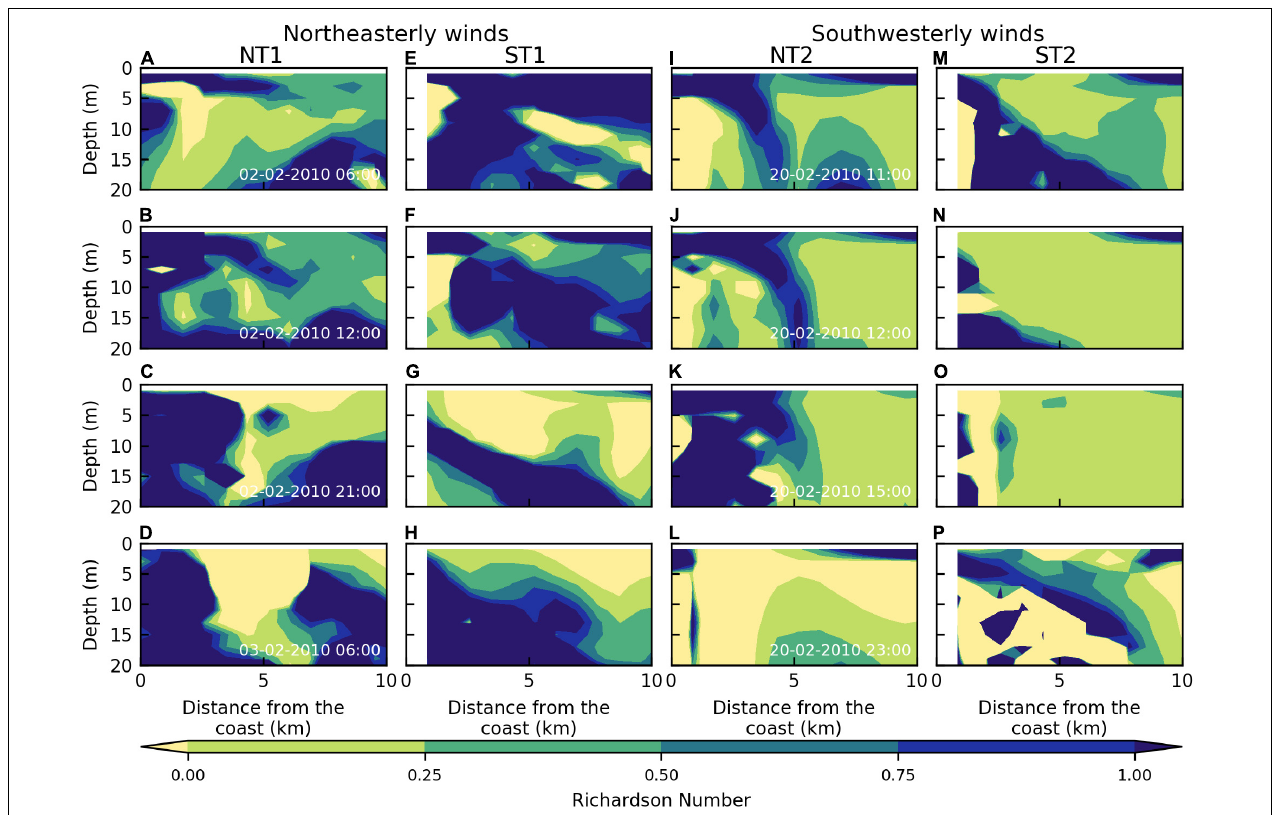
FIGURE 12 | Vertical variability of Richardson Number in transects (A–D) NT1 and (E–H) ST1 during northeasterly winds and (I–L) NT2 and (M–P) ST2 during southwesterly winds. river plume and the oceanic waters, as indicated by Richardson Number > 0.25 near the river mouth ( Figures 12I,M ).